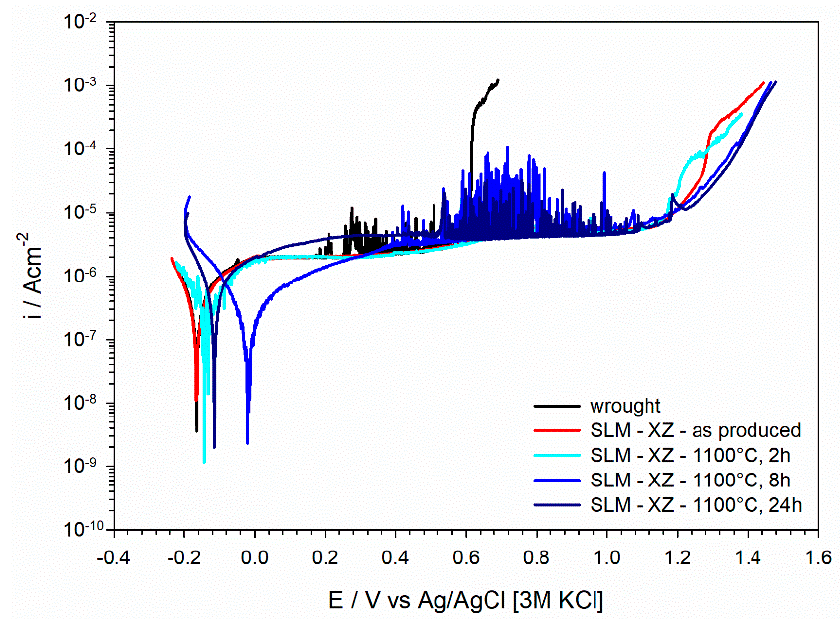
Figure 11. Potentiodynamic polarization curves in 3.5% NaCl solution.